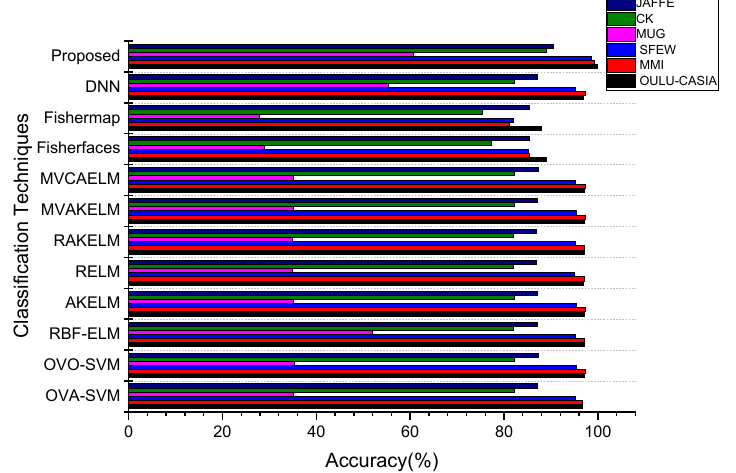
Figure 12. Comparison of accuracies achieved by JAFFE for different discriminant analysis methods.